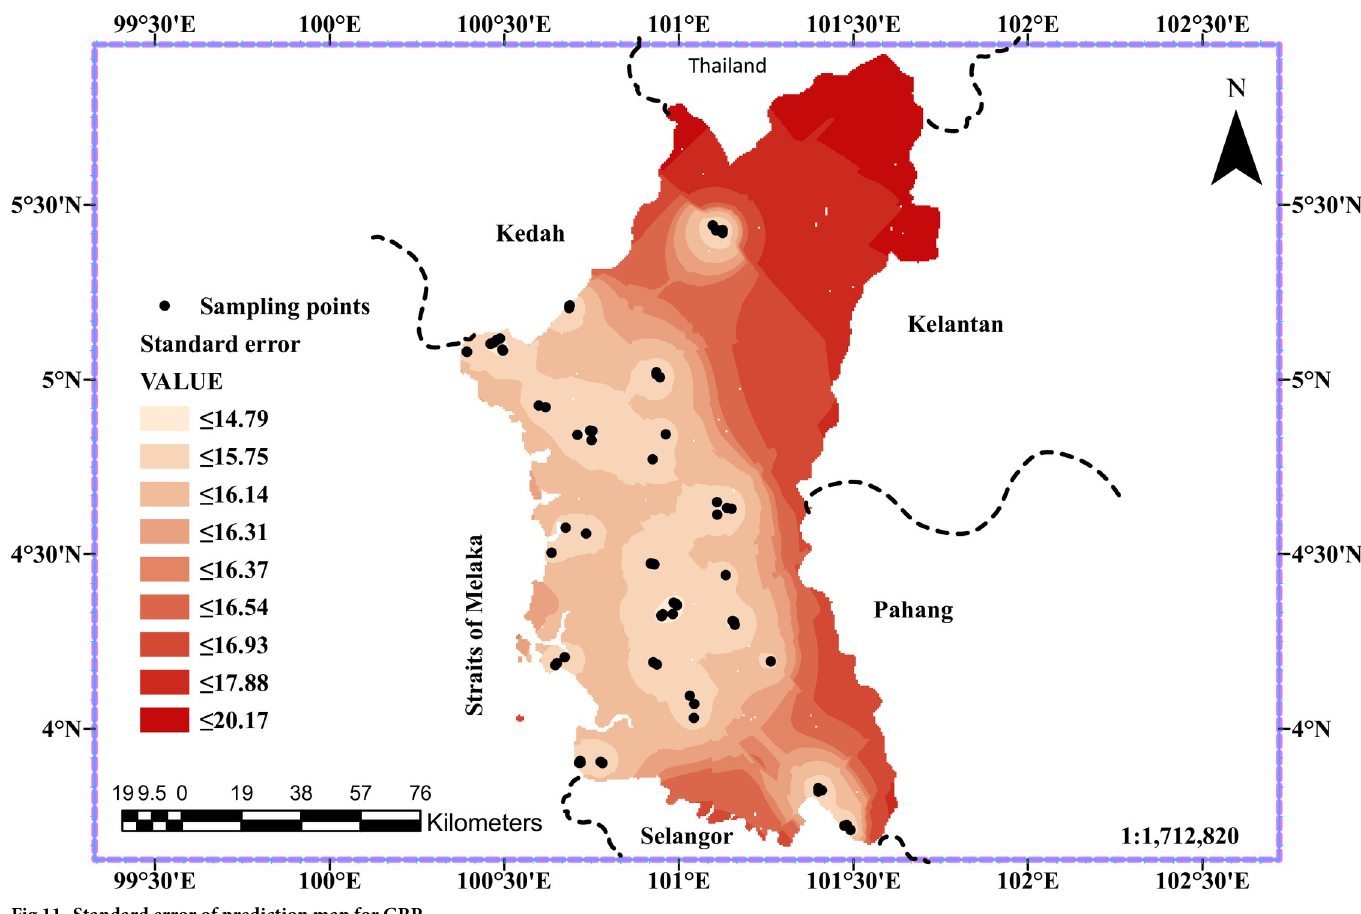
Fig 11. Standard error of prediction map for